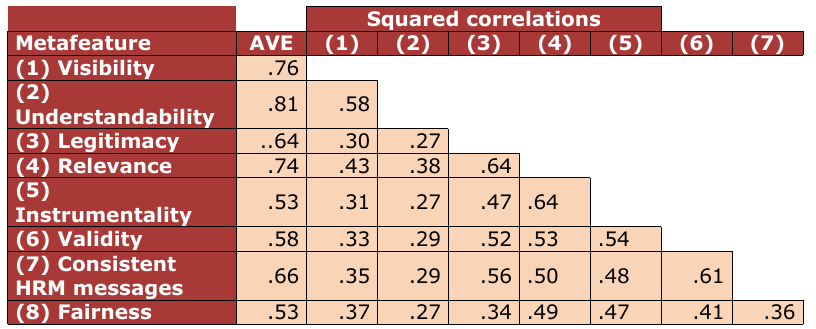
Table 2. Discriminant validity: Comparison of AVE with the squared correlation of the